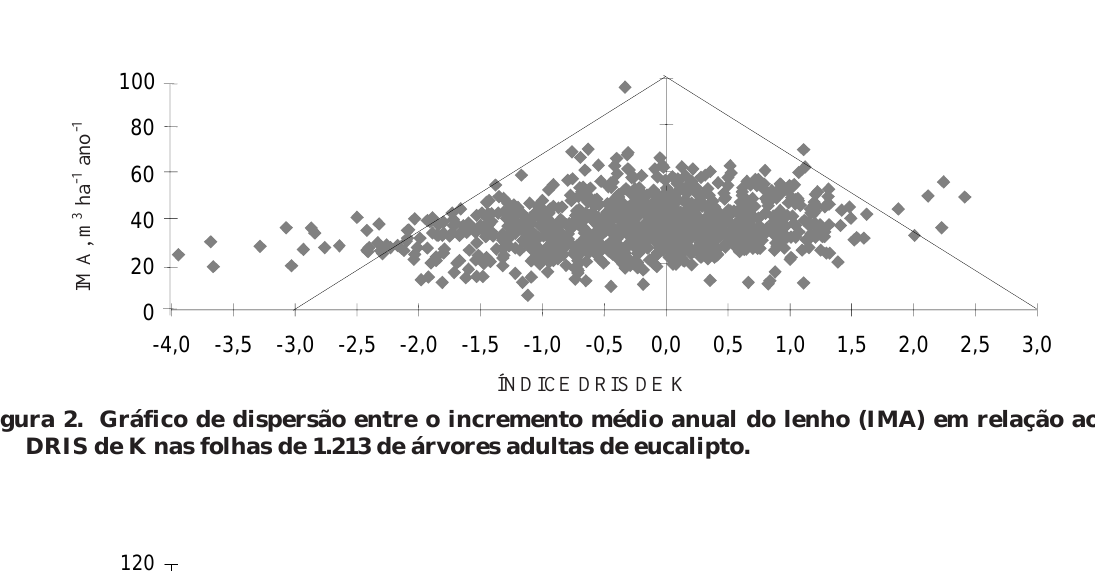
eucalipto.Figura 1. Gráfico de dispersão entre o incremento médio anual do lenho (IMA) em relação ao teor de K nas folhas de 1.213 árvores de eucalipto. CR NCO = nível crítico ótimo; LIFO = limite inferior da faixa ótima e; LSFO = limite superior da faixa